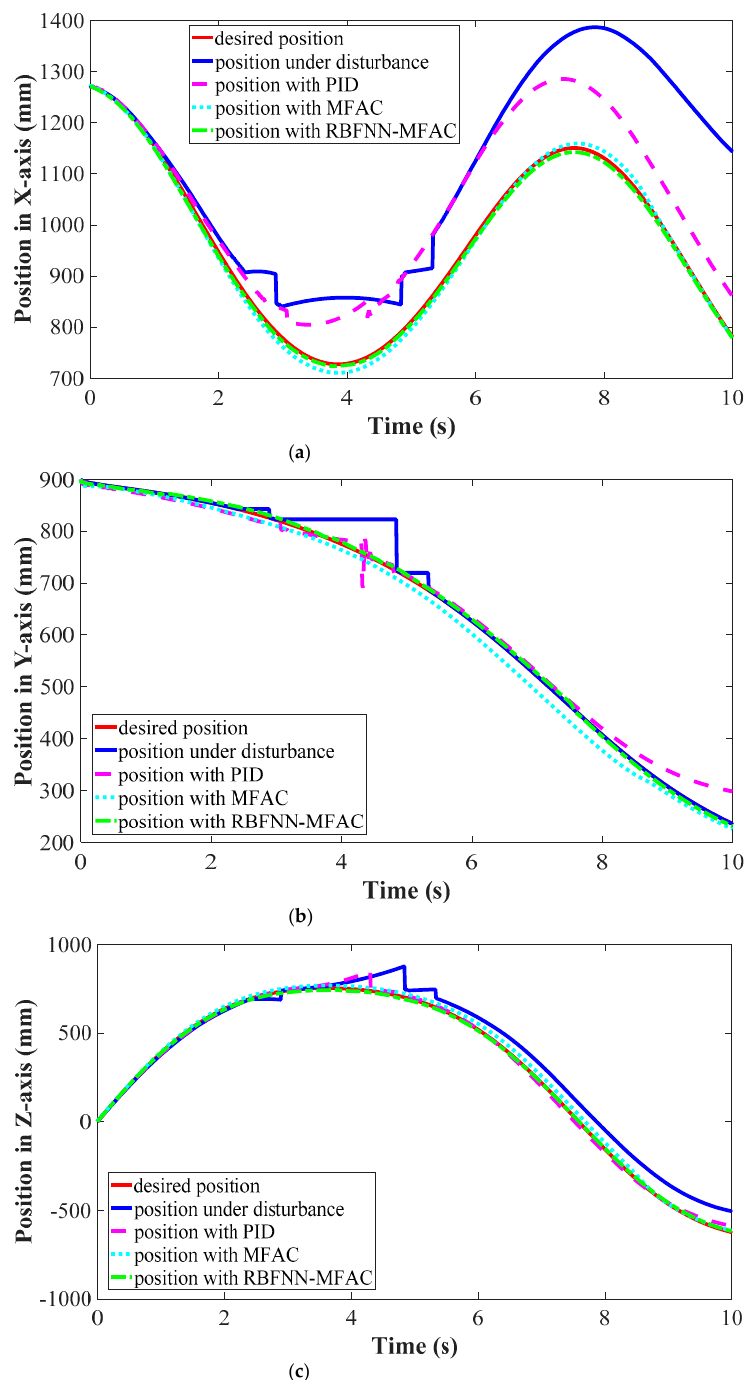
Figure 12. Position Tracking Accuracy along Various Axes of Cartesian Coordinates. ( a ) Position Tracking Accuracy along the x Axis; ( b ) Position Tracking Accuracy along the y Axis; ( c ) Position Tracking Accuracy along the z Axis.